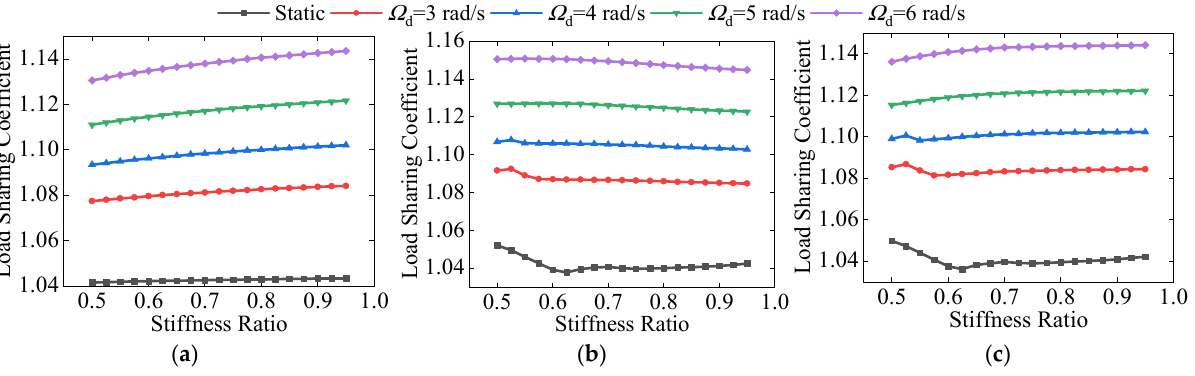
Figure 22. Effect of reducing bearing stiffness on LSC at different LAV. ( a ) Sun bearing; ( b ) Planet bearing; ( c ) Sun + Planet bearing.